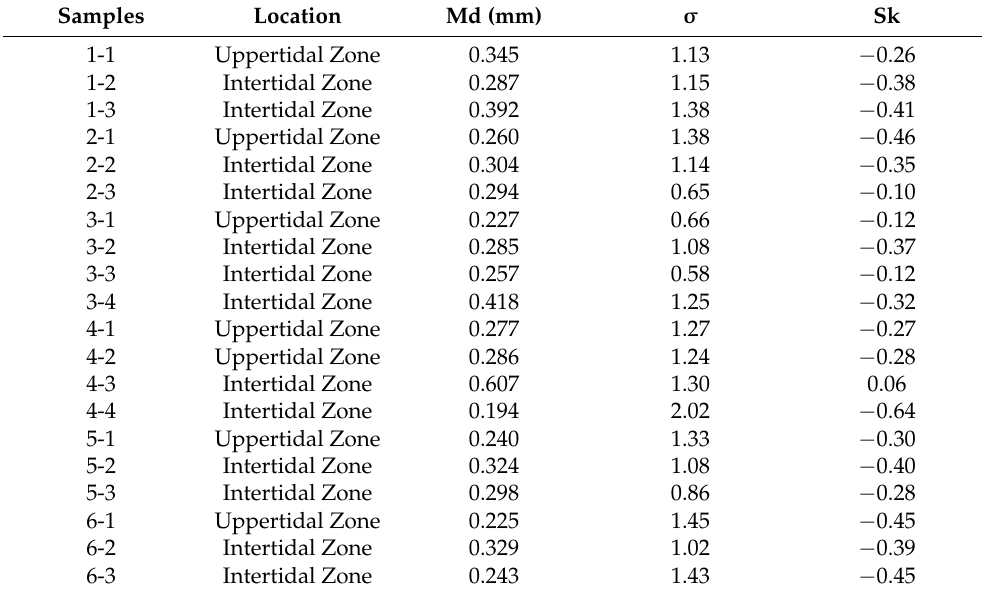
Table A1. Grain size parameters of beach sediment